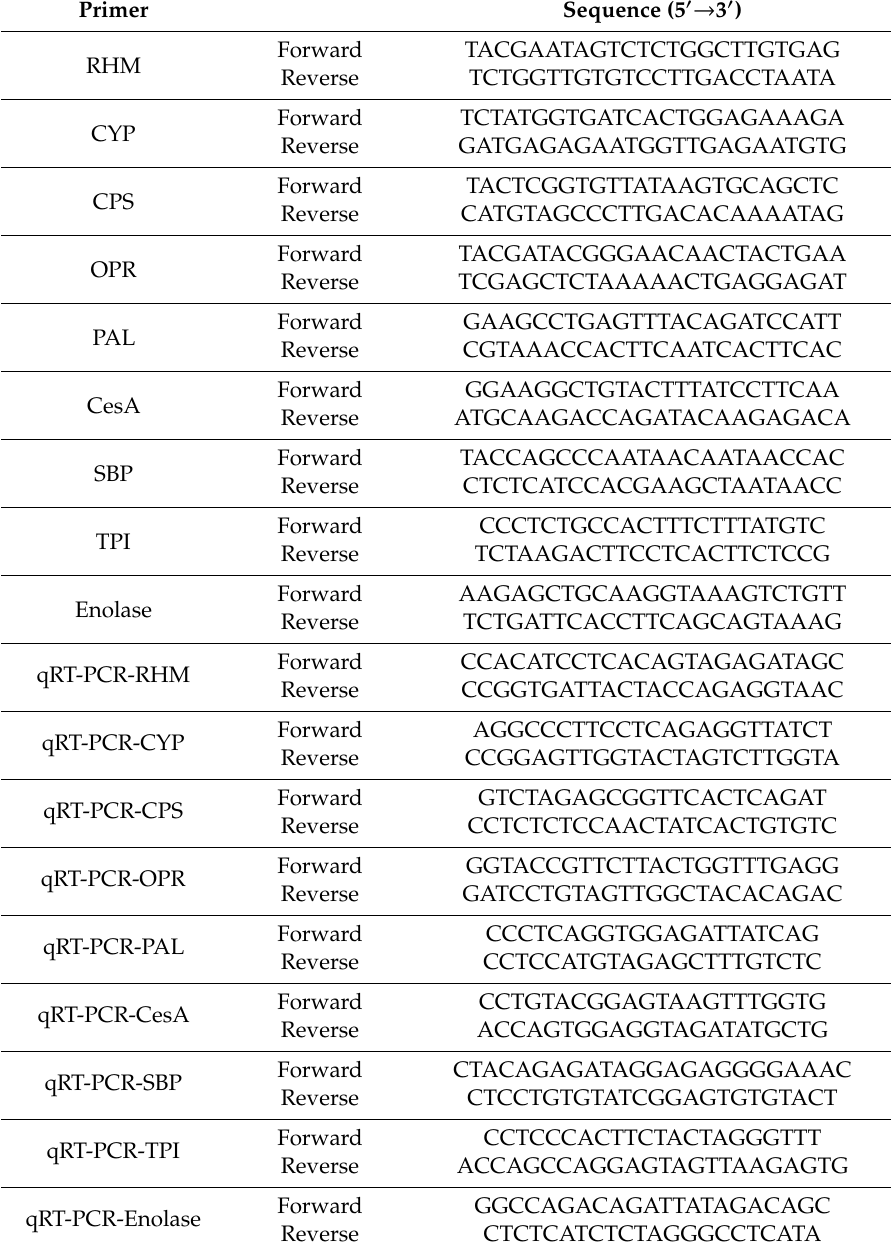
Table A1. Primers used in this